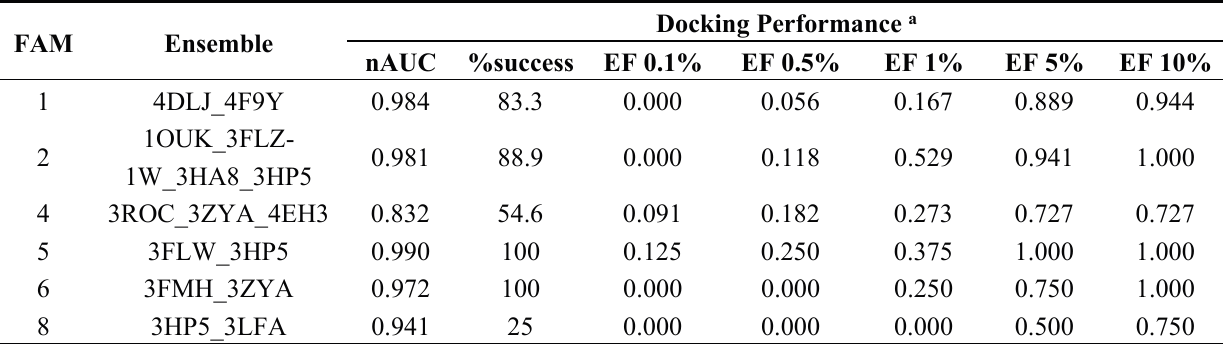
Table 3. Best performing ensemble for each TI-I family.